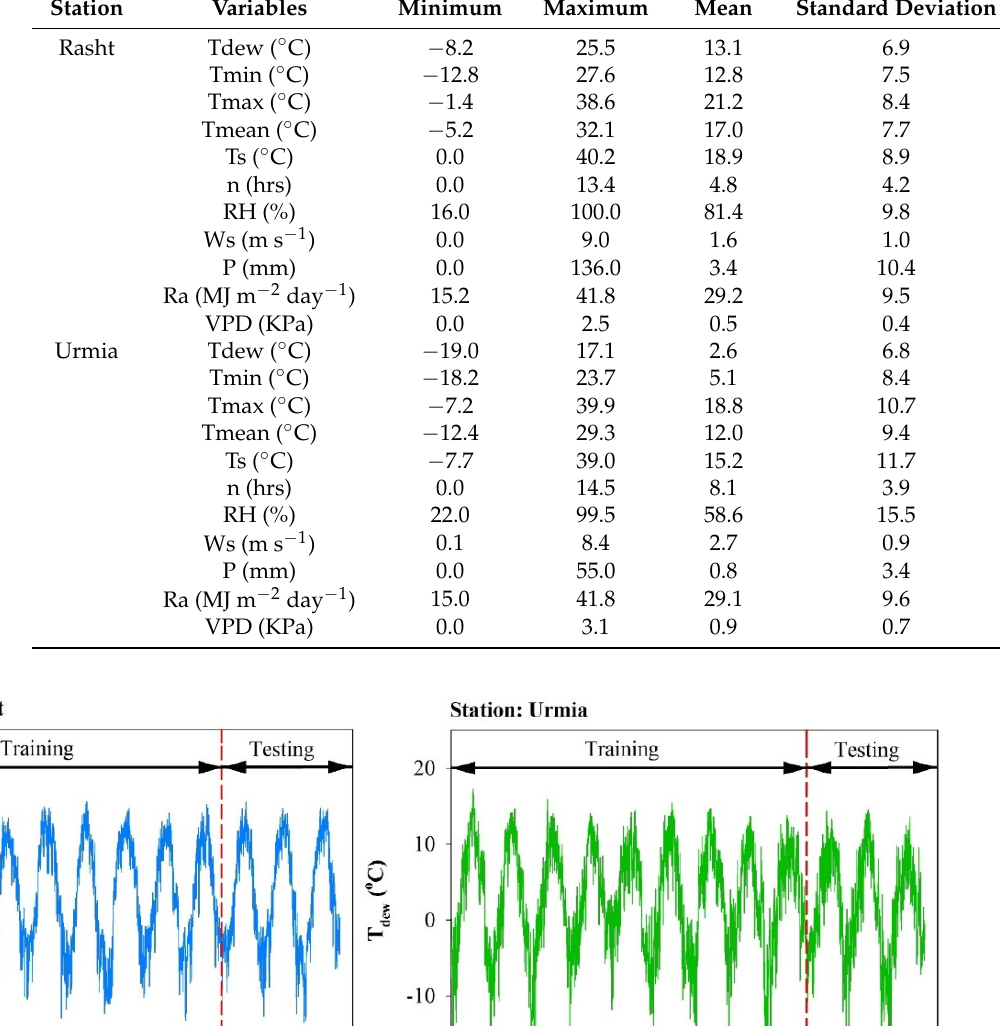
Table 1. Daily statistical parameters of the weather variables for the studied stations during 2006– 2017.